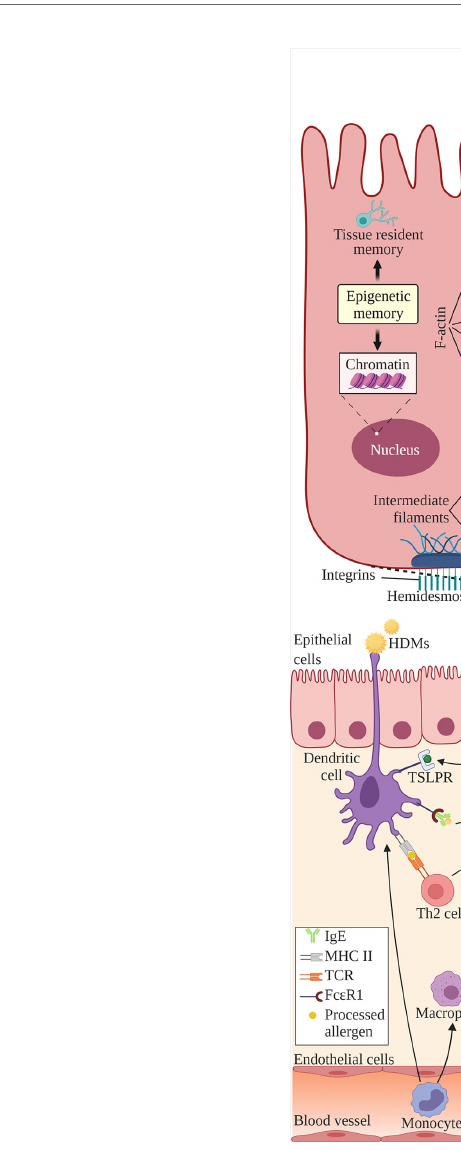
FIGURE 1 | The structure of nasal epithelial barrier comprises of tight junction (TJ), adherens junction, desmosomes and hemidesmosomes. TJs are composed of occludin, claudin and JAMs that span the intercellular space and intracellular adaptor proteins ZO. Adherens junctions are composed of E-cadherins and adaptor proteins. Desmosomes consist of desmoglein and desmocollin proteins that bind internal adaptor proteins. F-actin and intermediate fi laments act as cytoskeleton for these cell junctions. Hemidesmosomes comprise of plectins that link to the intermediate fi laments and integrins, the transmembrane linkers of extracellular matrix and actin cytoskeleton. Epithelial cells secrete antimicrobial substances such as defensins and conduct mucociliary clearance. Epithelial activation by airborne allergens during allergic response in AR leads to the activation of epithelial cells and release of epithelial-derived cytokines TSLP, IL-25 and IL-33. This triggers subsequent activation of ILC2s and production of Th2 cytokines such as IL-4, IL-5, IL-6 and IL-13. Released cytokines promote DCs where they present antigens and activate naïve B cells to induce IgE class switching and maturation into plasma cells, which produce IgE. Secreted IgE binds the Fc ϵ RI receptor on submucosal mast cells, leading to the release of preformed mediators such as histamine and in fl ammatory cytokines. In the late allergic phase, recruited eosinophils and basophils release mediators that further contribute to AR symptoms via epithelial damage and microvascular leaking. Blood-derived monocytes differentiate into DCs and macrophages that promote allergic responses. The overproduction of Th2 cytokines by a variety of cells suppresses the transcription of TJ molecules causing the breakdown in the nasal epithelial barrier of AR patients. Sensory neuron release NMU, SP and CGRP upon activation at sensory nerve endings. NMUR1 expressed on ILC2 intensi fi es the in fl ammatory response in the presence of IL ‐ 25, IL ‐ 33, and TSLP. TRP and tuft cells also have roles in regulating epithelial barrier. Epithelial barrier is also regulated by epigenetic changes through histone modi fi cation by HDACs and miRNAs. Epithelial cells exhibit epigenetic memory by embedding the memory of previous encounters within their chromatin, and tissue-resident memory cells preserve the epithelial barrier. DC, dendritic cell; ECP, eosinophil cationic protein; MBP, major basic protein; MHC, major histocompatibility complex; IgE, immunoglobulin E; ILC2, type 2 innate lymphoid cell; JAMs, junctional adhesion molecules; TCR, T cell receptor; Th2, T helper 2; TSLP, thymic stromal lymphopoietin; TSLPR, thymic stromal lymphopoietin receptor; ZO, zonula occludens; HDAC, histone deacetylases; miR, microRNA; NMU, neuromedin U; NMUR1, neuromedin U receptor 1; SP, substance P; CGRP, calcitonin gene-related peptide; TRP, transient receptor potential. Created with